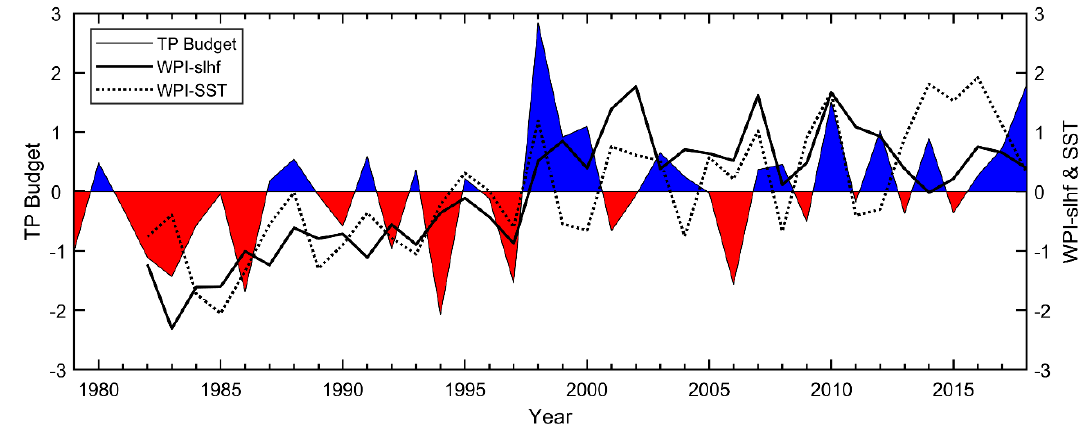
Figure 8. The standard time series of summer WVB in the TP (the shaded area) and the warm pool index (WPI)-slhf (solid black line) and WPI-SST (dashed black line).